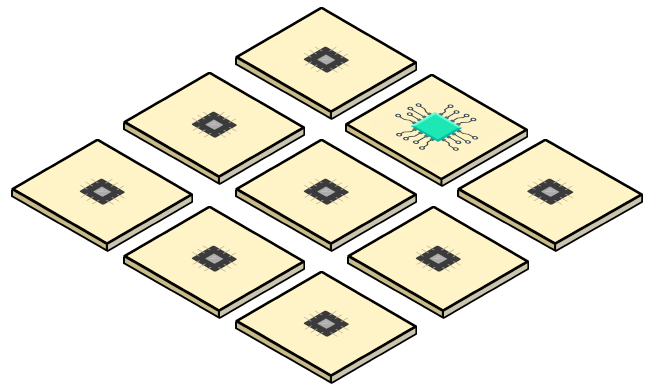
Figure 5. Grid-based connection of individual force